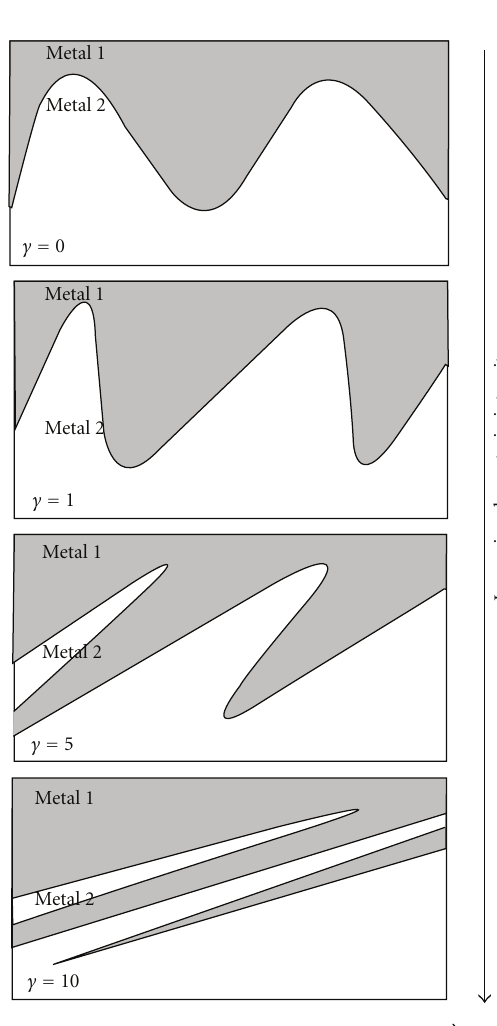
Figure 6: Scheme leading to asperity tip fracturing and incorpora- tion into second material during sliding under friction conditions [9]. γ : shear